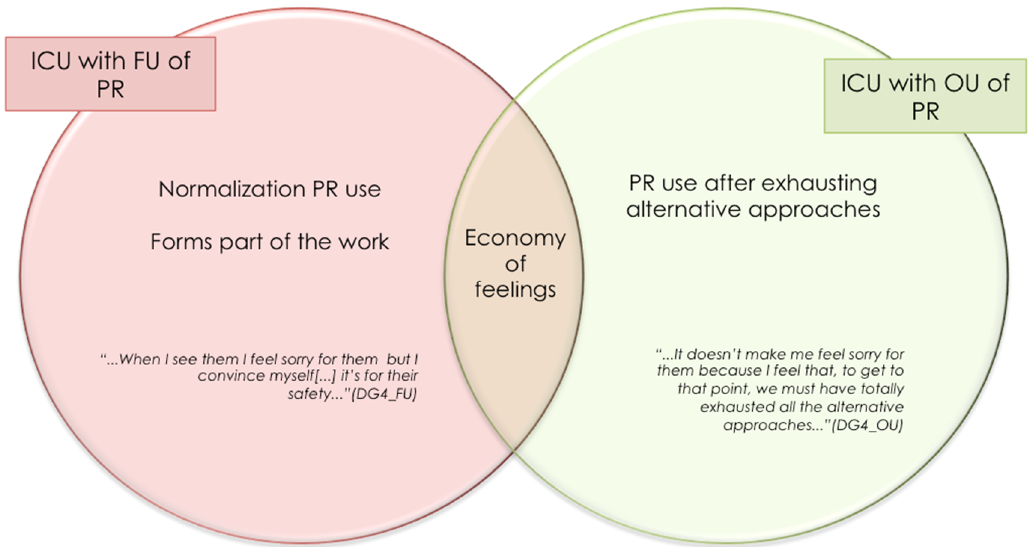
Figure 10. Venn diagram: economy of feelings with regard to the use of physical restraints in intensive/critical care units with frequent versus occasional use of restraints. Abbreviations: PR: physical restraint; ICU: intensive/critical care unit; FU: frequent/systematic use; OU: occasional/individualized use.